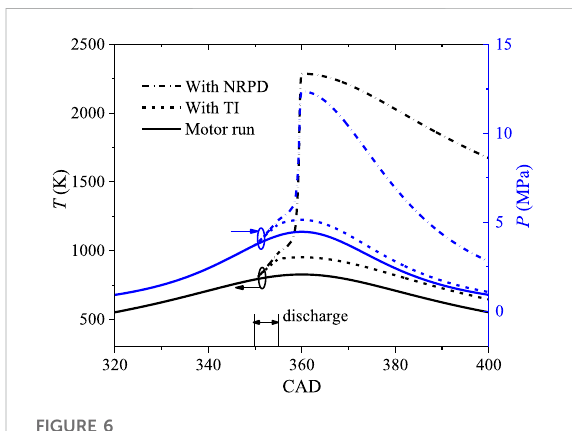
FIGURE 8 Evolution of temperature and HRR with a crank angle degree for cases 1 –